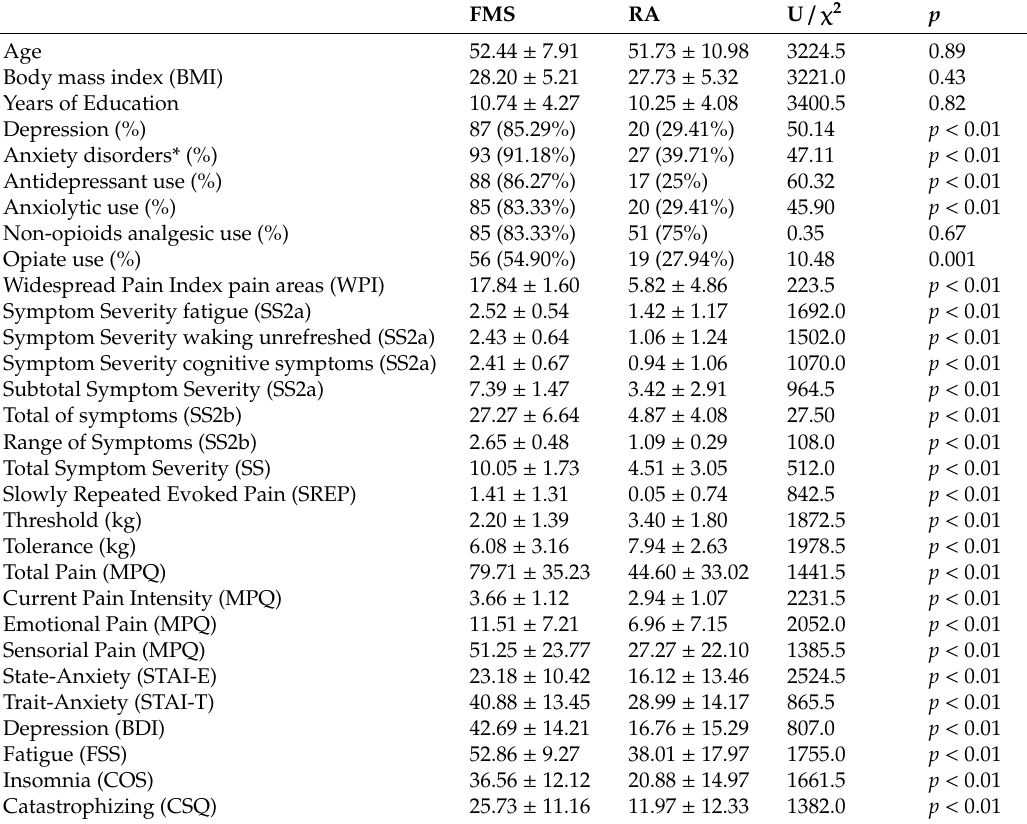
Table 1. Sociodemographic data, clinical variables and questionnaire scores in fibromyalgia syndrome (FMS) ( n = 102) and RA ( n = 68) patients (M ± SD or number and %) Results of group comparisons (Mann–Whitney U-tests or χ 2